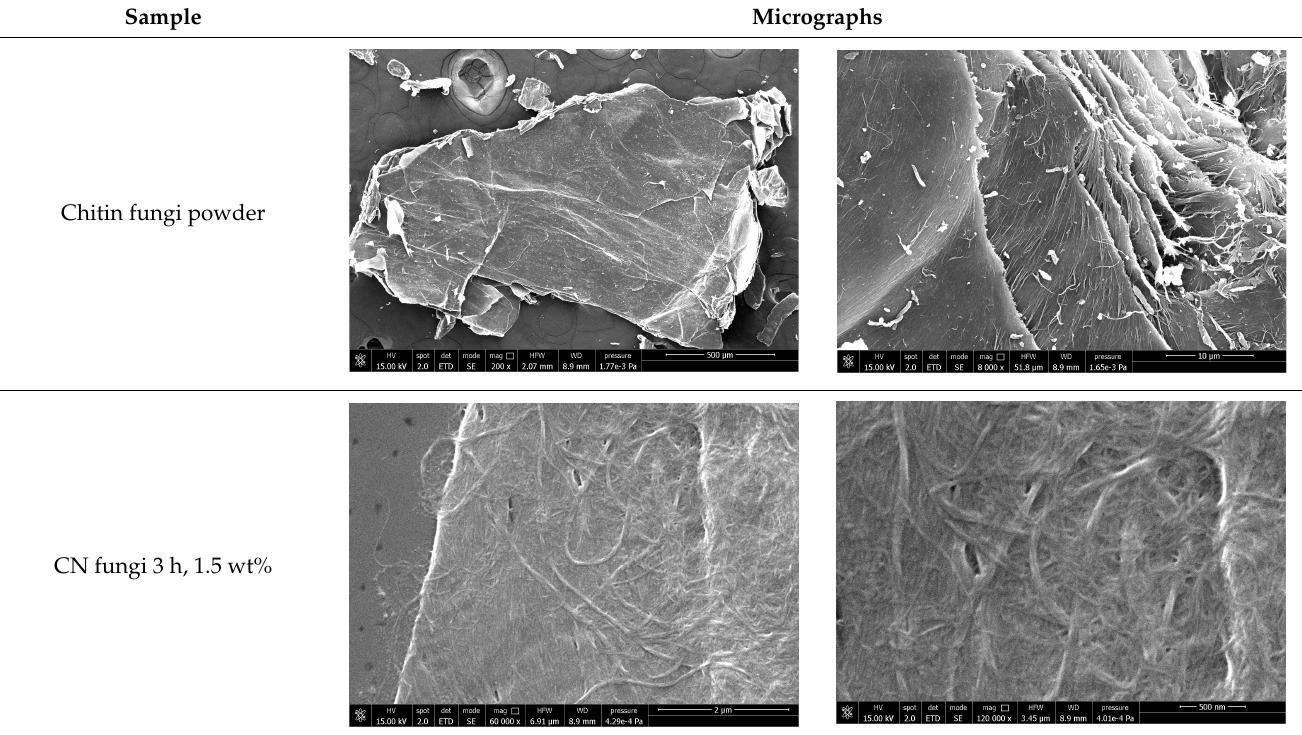
Figure 3. Comparison between ATR-IR spectra of chitin produced by shrimp and fungi. Both ATR-IR spectra reported in Figure 3, showed the typical amide (1310 cm − 1 , 1550 cm − 1 and 1650 cm − 1 ) and amine signals (1620 cm − 1 , 3100 cm − 1 and 3255 cm − 1 ). Infrared spectroscopy did not evidence any substantial differences between spectra showing that the different source did not significantly affect the chemical structure of the chitin. Table 5. Surface analysis of PBSA/PHBV films coated with chitin from fungi. Covered Surface Ratio (%)